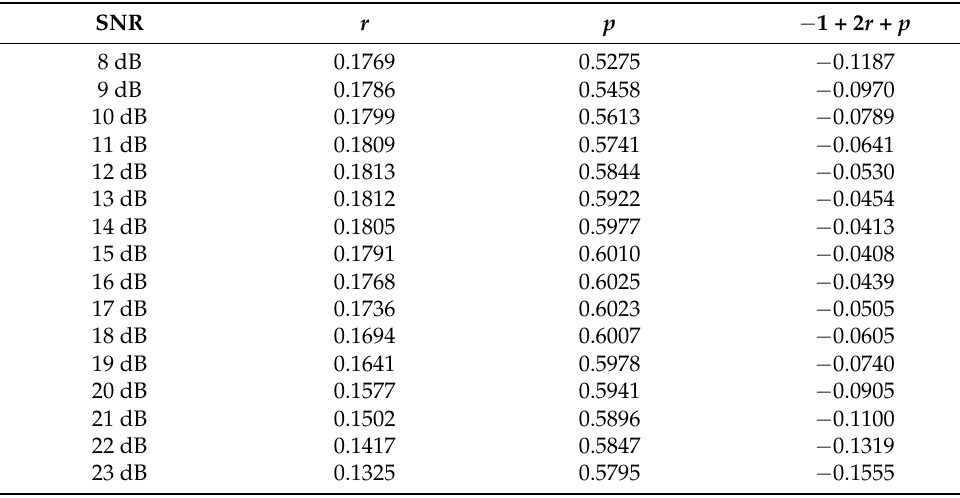
Table 2. Effect of r and p coefficient for three-way GPR